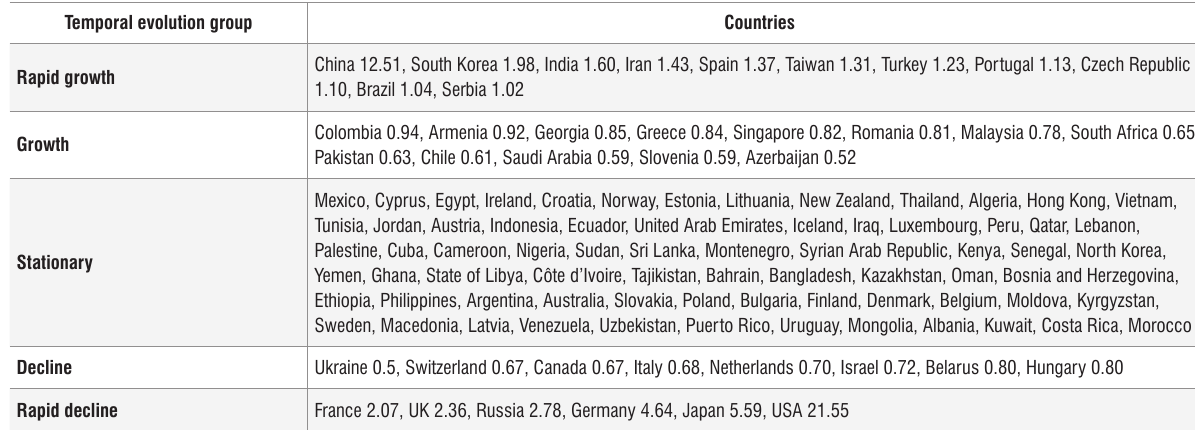
Table 3: Groups of countries based on temporal evolution in Pm-Cm diagram Temporal evolution group Countries Rapid growth